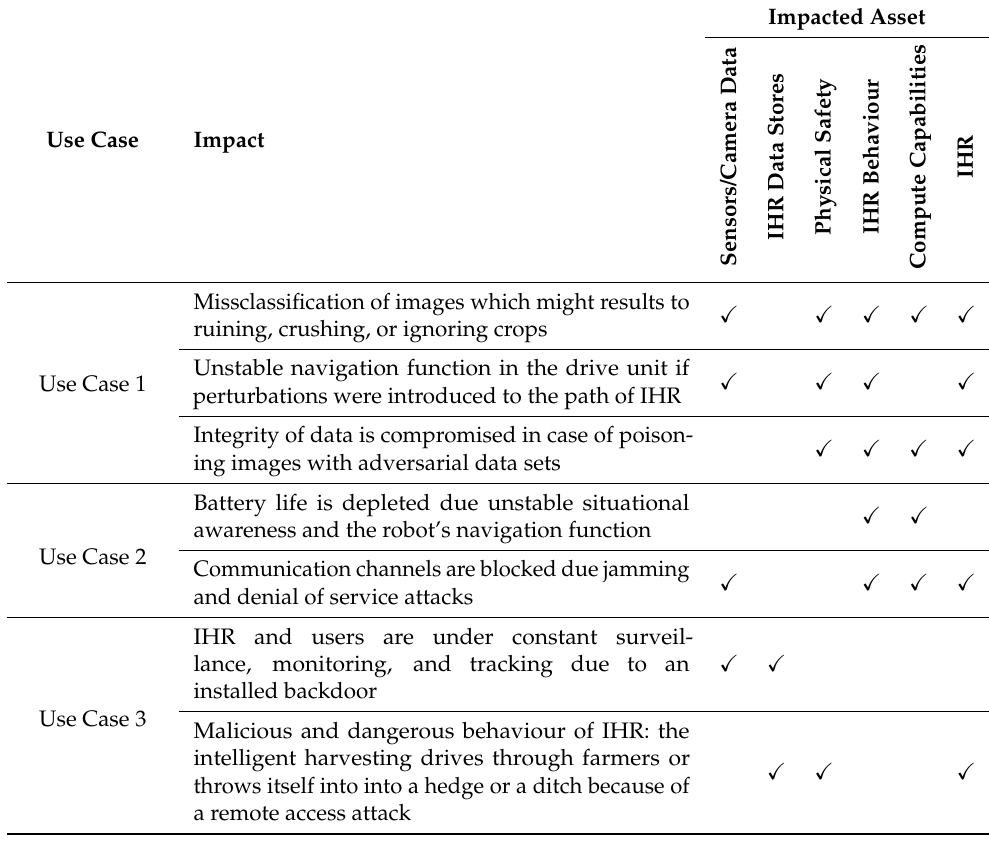
Table 3. Technical impact of the studied use